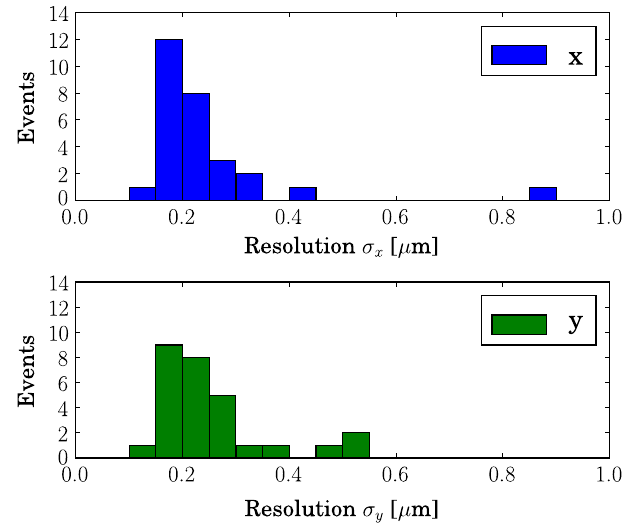
FIG. 19. Resolution of attenuated C -band BPMs in x (top) and y (bottom).